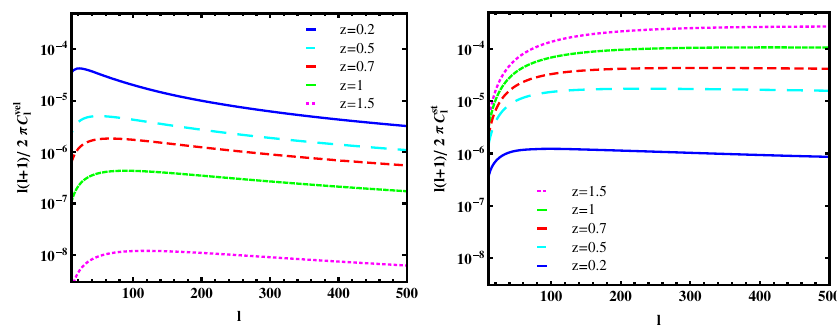
Fig. 11 Left: The velocity contribution C vel (cid:23) as a function of (cid:23) for various redshifts. Right: The standard contribution C st (cid:23) as a function of (cid:23) for various